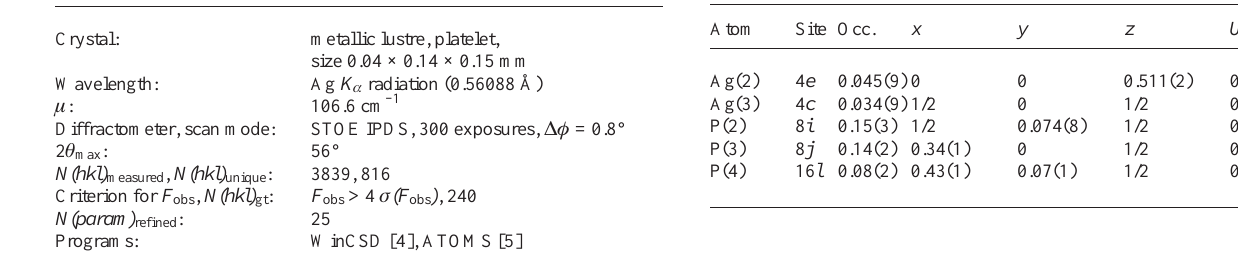
Table 2. Atomic coordinates and displacement parameters (in Å 2 ) . Table 1. Data collection and